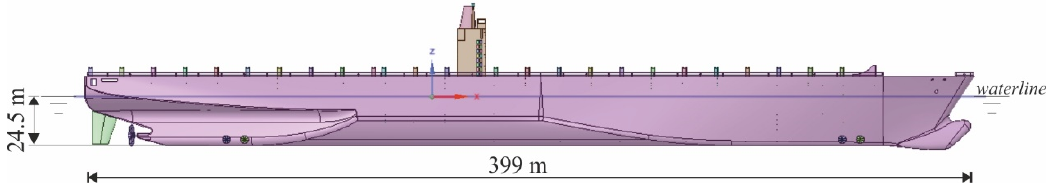
Figure 2. Side view of the analyzed 18270 20-foot equivalent unit (TEU) container ship. J. Mar. Sci. Eng. 2020 , 8 , x FOR PEER REVIEW